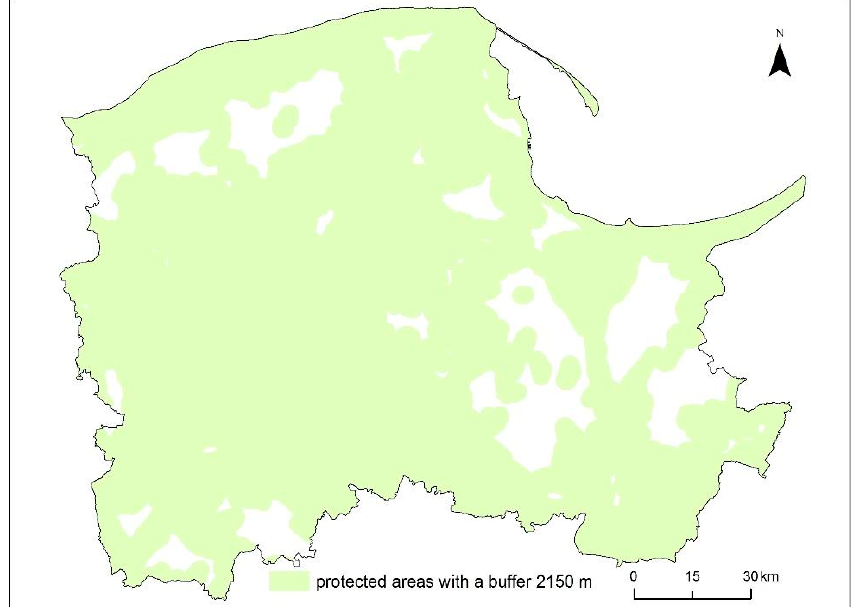
Figure 3. Protected areas with a buffer of 2150 m (own elaboration).